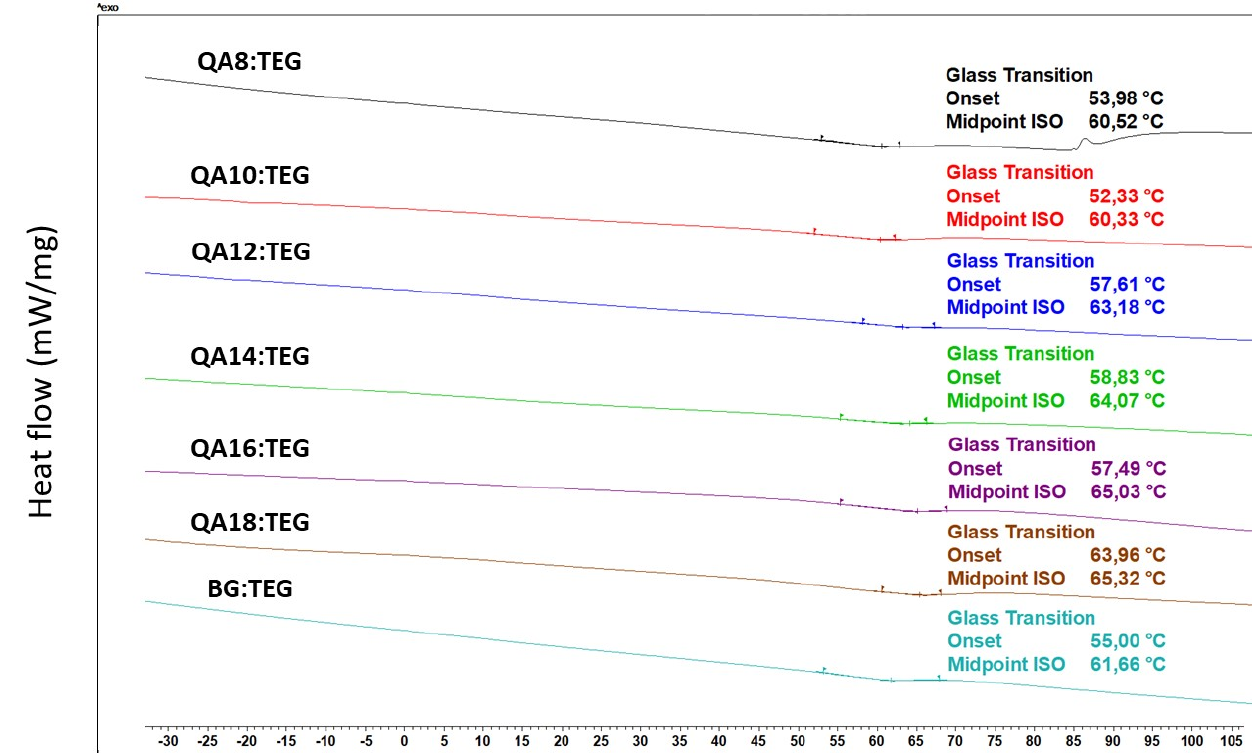
Figure 3. The representative FT IR spectra of the QA16:TEG: ( a ) liquid monomer composition and ( b ) copolymer.